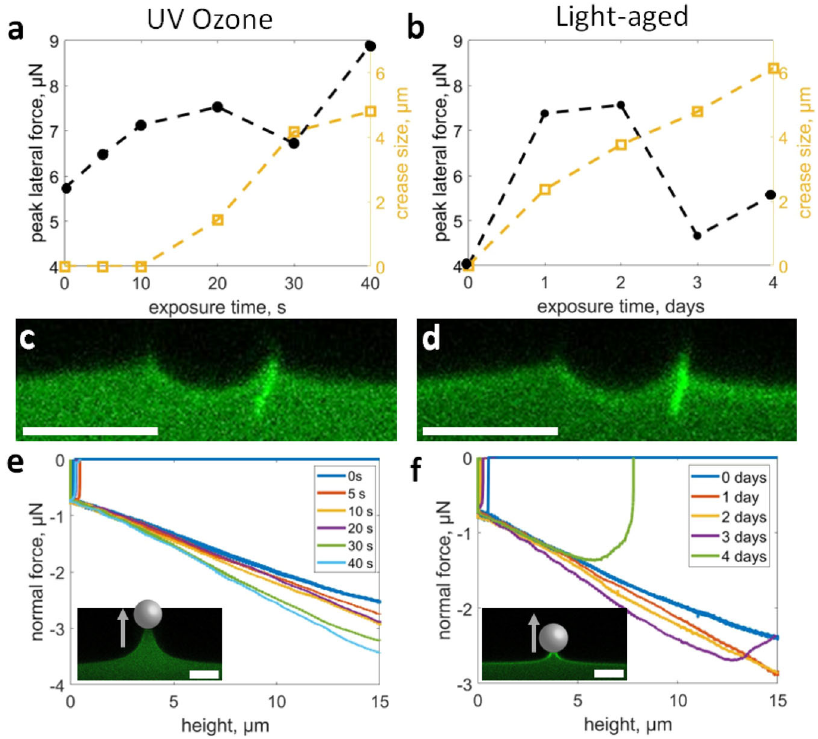
Fig. 3 | Peak lateral force, crease size, and normal adhesion with surface treatments. a Crease size and F peak as a function of increasing UV ozone time. b Creasesizeand F peak asafunctionofincreasing timeinambientlightconditions. c A crease on a 40s UVO-treated surface. d A crease on a 3-day light-aged surface. e Verticaladhesionforcevs.heightcurvesofasurfaceexposedtoUVOfordifferent